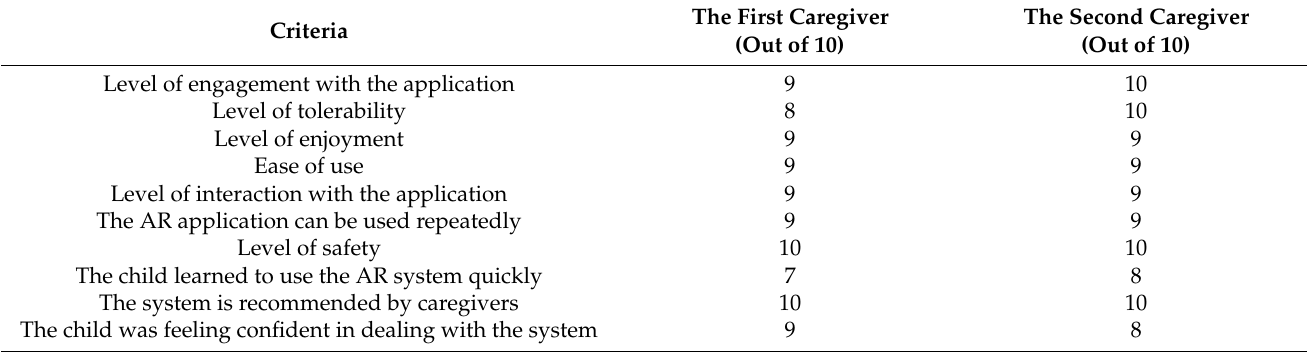
Table 9. The assessment of the application by caregivers for ASD children.